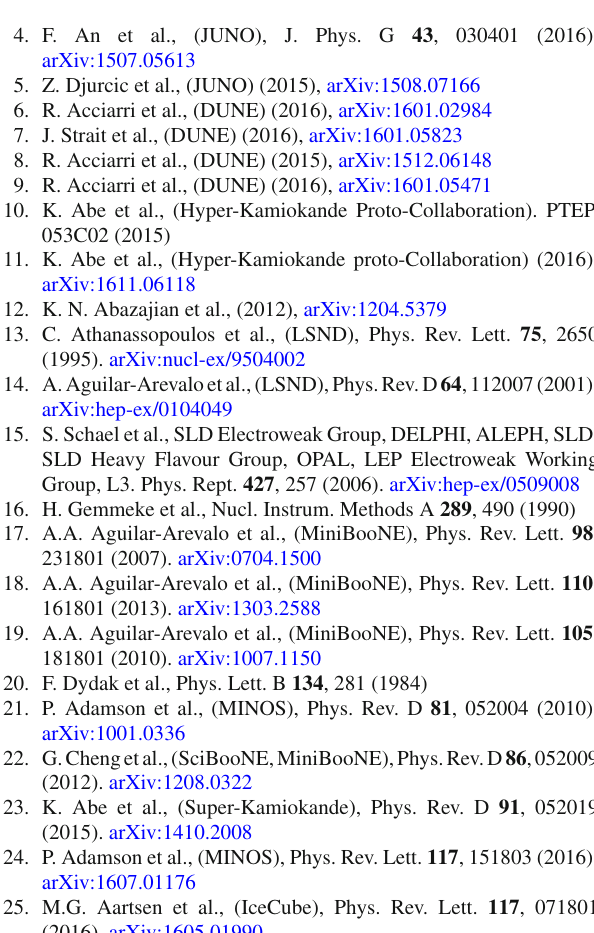
Fig. 6 Impact of disappearance channel on removing the (cid:2) m 2 fake solution. The blue lines show the χ 2 as a function of (cid:2) m 2 (test) for the appearance channel only for T2HK (left panel) and